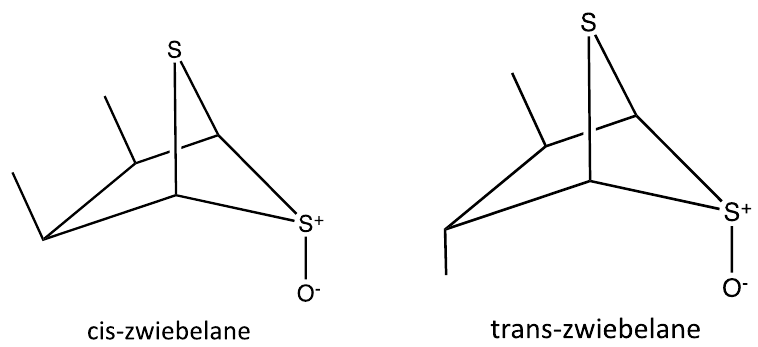
Figure 2. Chemical structures of sulfur-containing secondary metabolites commonly found in onion.